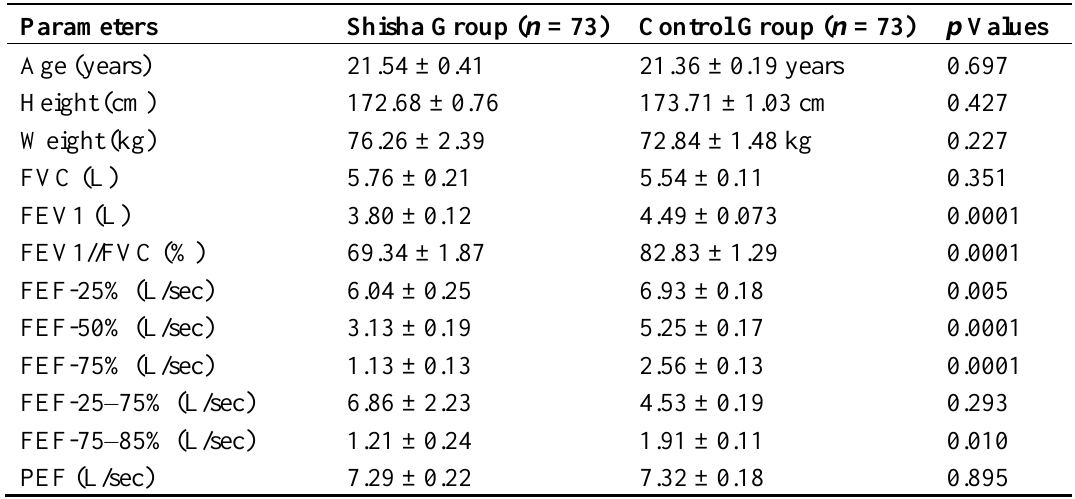
Table 1. Comparison of various lung function parameters between Shisha Smokers compared to their matched control group.